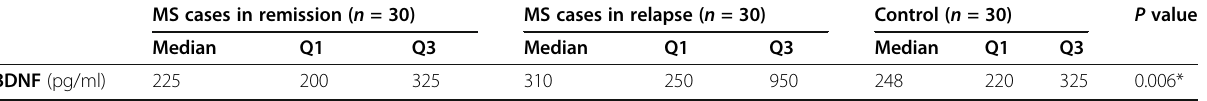
Table 3 The BDNF level for MS patients in remission, MS patients in relapse, and control